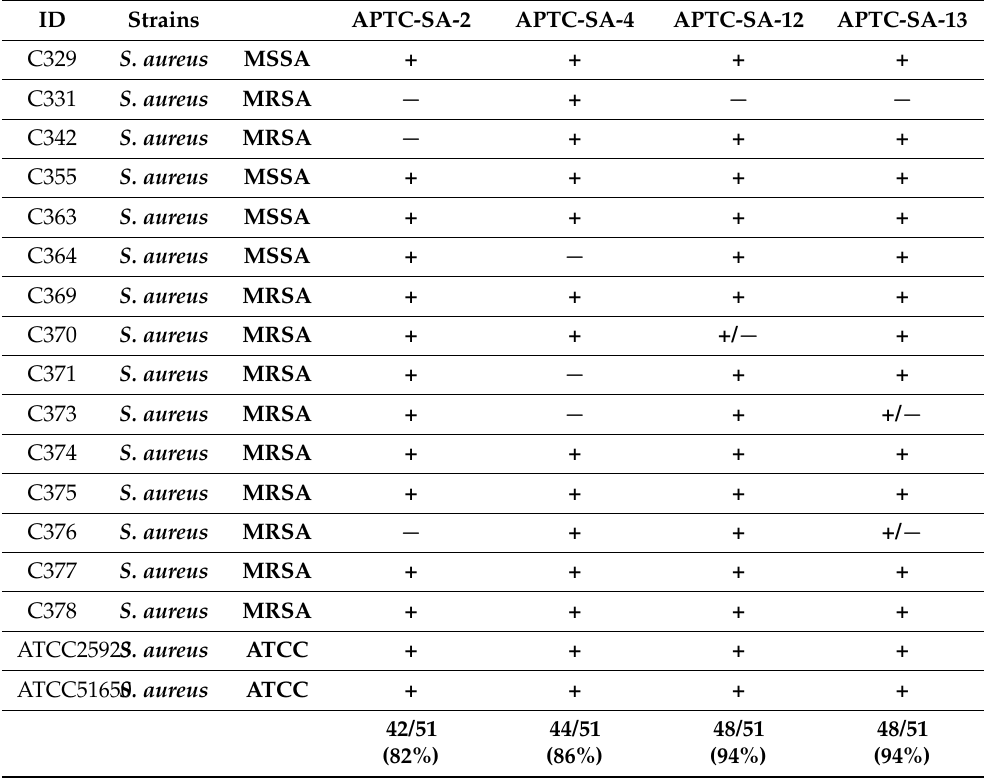
Table 1. Cont. ID Strains APTC-SA-2 APTC-SA-4